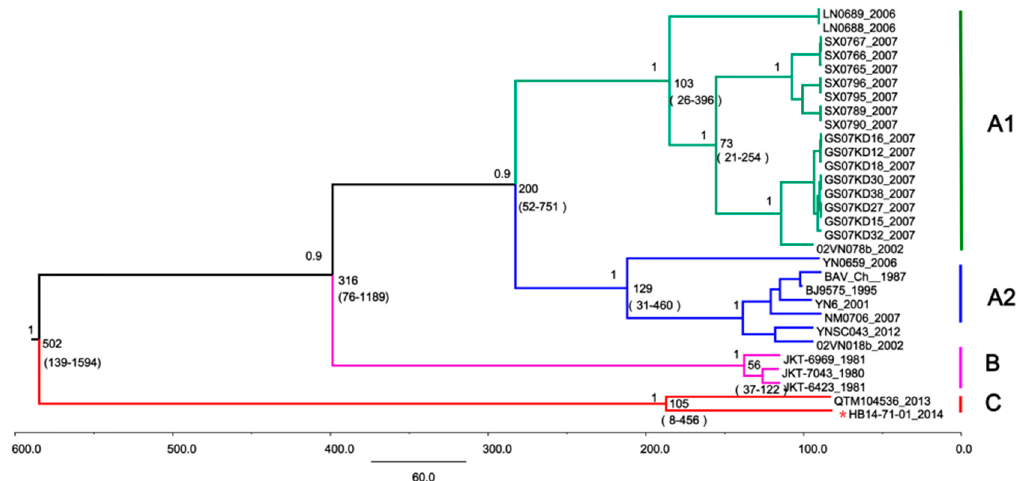
Figure 3. Time-scale evolutionary analysis of BAVs based on segment 12. The tree identifies three distinct lineages: genotypes A (including subgroups A1 (green) and A2 (blue)), B (violet), and C (red). The estimated most recent common ancestors (MRCAs) of these lineages (with 95% highest posterior density (HPD) values in parentheses) are presented. The newly isolated Hubei strain HB14-71-01 is indicated with a red star.